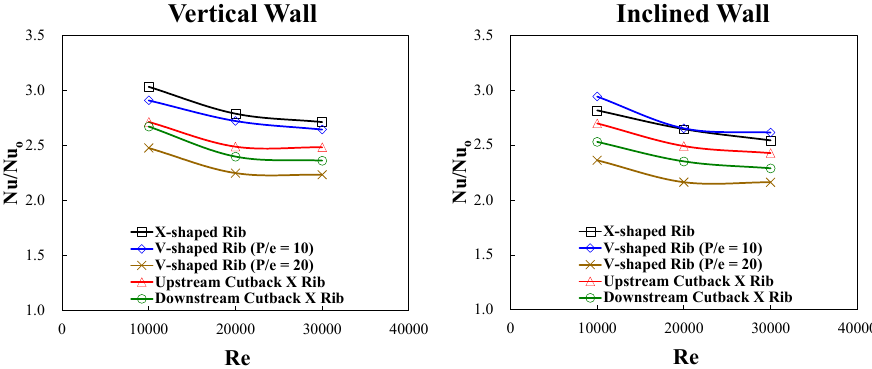
Figure 10. Average Nusselt number ratios on the vertical wall and inclined wall.